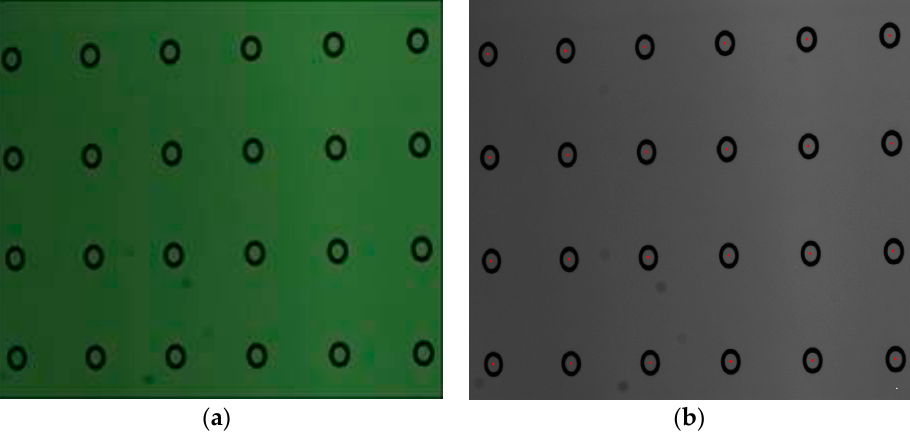
Figure 2. Image of hollow ring marker matrix captured by the camera: ( a ) texture image and ( b ) red dots representing the center of each hollow ring marker.